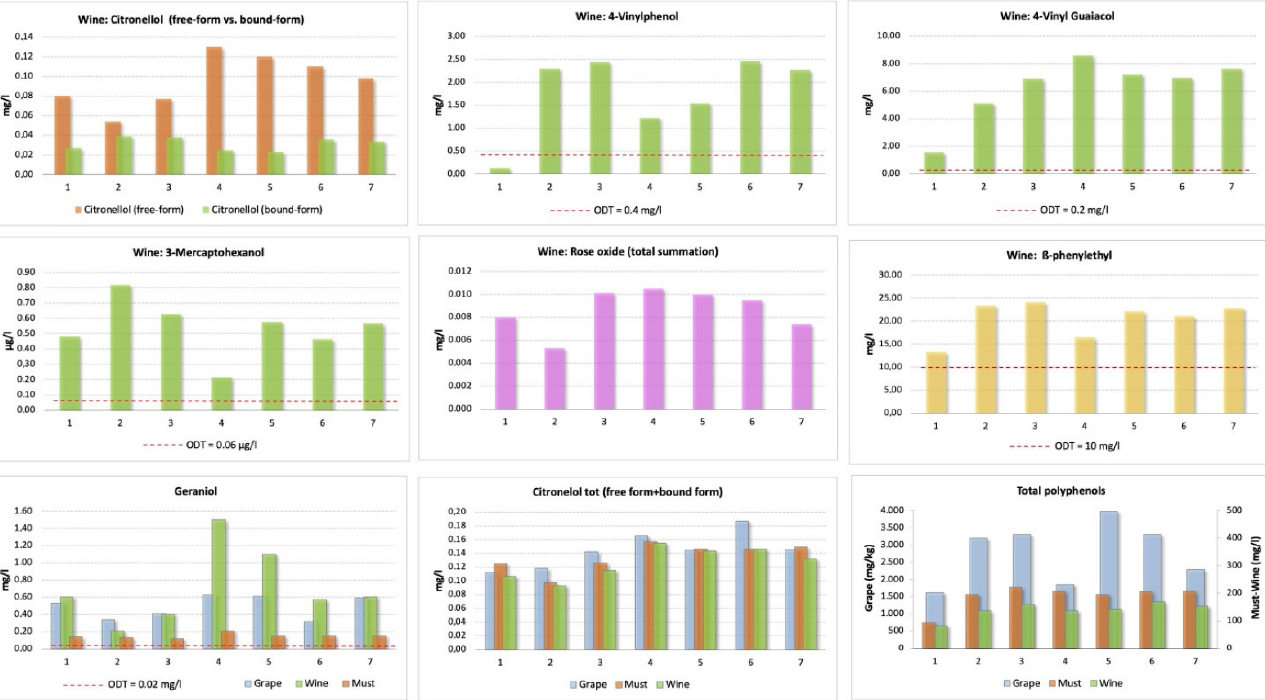
Figure 13. Results from the targeted chemical–oenological analysis on grapes, musts and wines, with concentration values of the elements measured in the seven vineyards’ products. The dotted red line represents the olfactory detection threshold of the aromatic molecules considered. For example, 4-vinylphenol, which contributes to a “Band-Aid” smell and is produced by yeasts [58], is very low in V1. A low total polyphenol content is also noted.